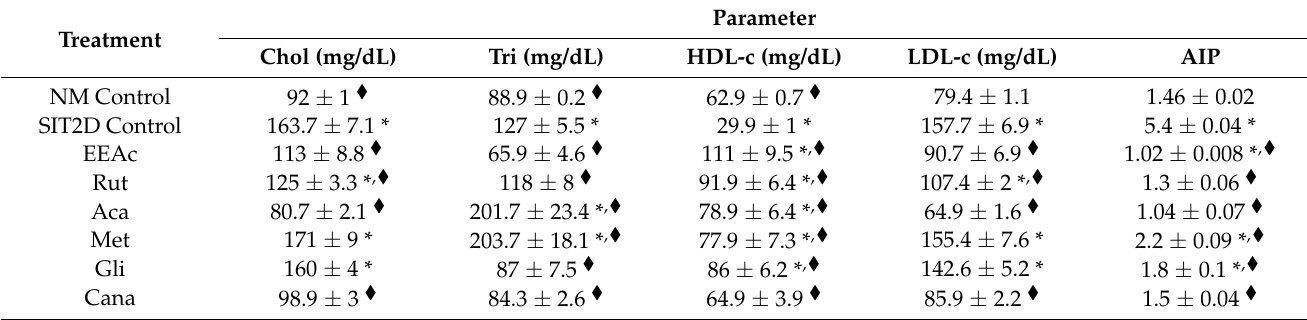
Table 2. Lipid profile values of groups treated with EEAc, rutin and oral antidiabetic drugs separately. Treatment